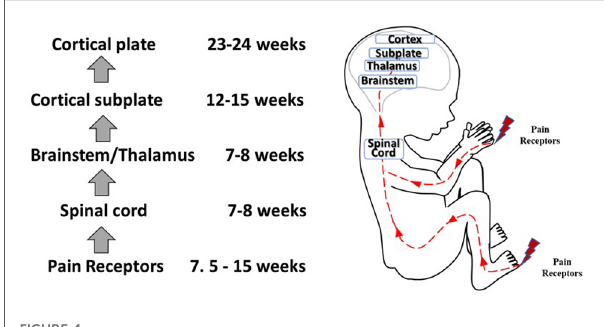
FIGURE 4 Development of nociceptive pathways. Peripheral pain receptors develop in most areas of the fetus between 7.5 – 15 weeks gestation (48). Afferents reach the spinal cord (49), the brainstem, and thalamus by 7 – 8 weeks (50, 51). Thalamic projections to the cortical subplate emerge at 12 – 15 weeks (14, 34, 52) and to the cortical plate after 23 – 24 weeks gestation